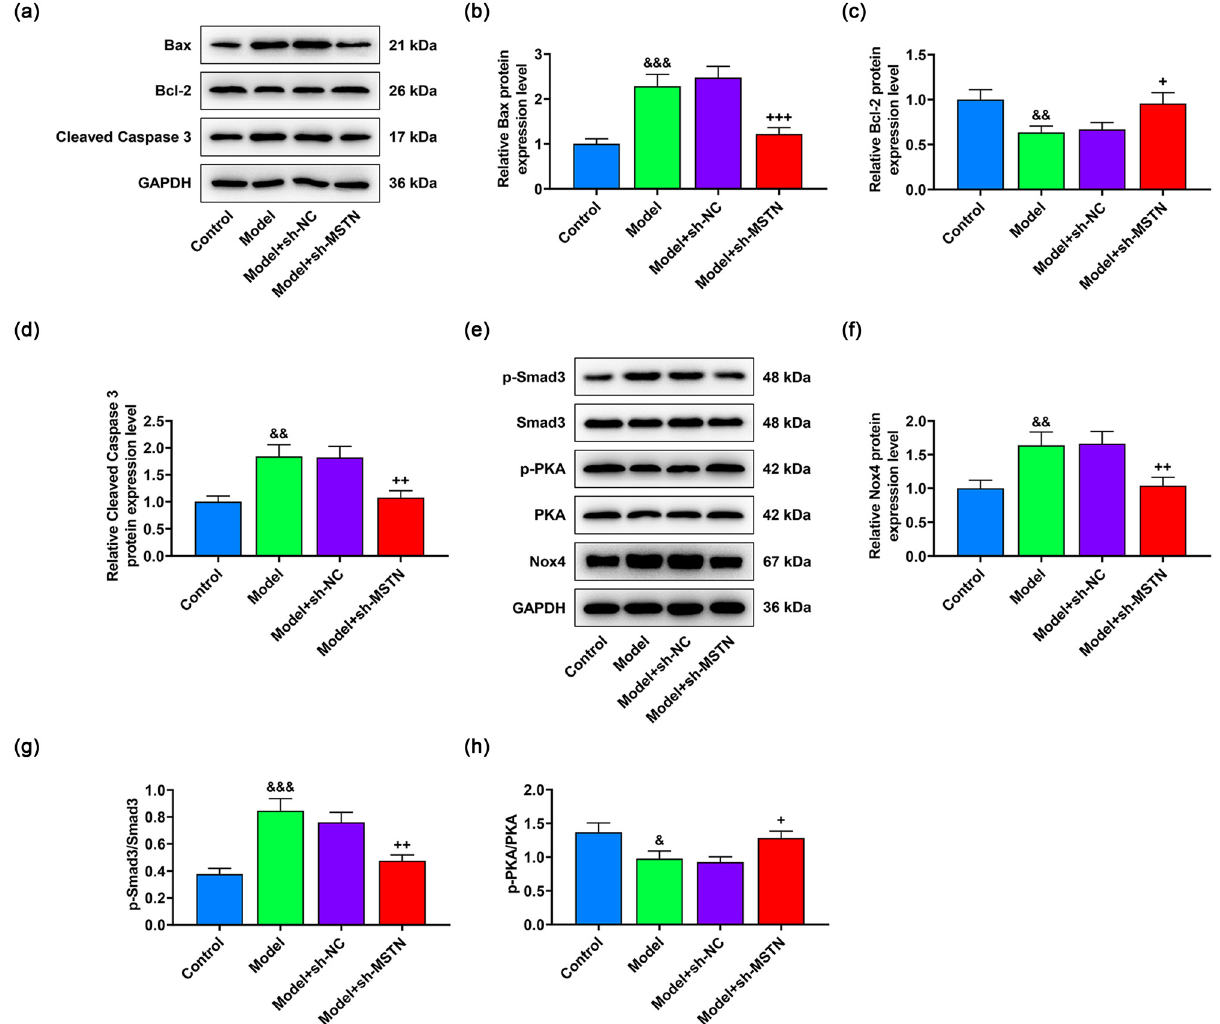
Figure 8: E ff ects of sh - MSTN on the apoptosis and expressions of Smad3/PKA/Nox4 signaling pathway - related proteins in MN model rats. MN model rats were induced by c - BSA and then subjected to injection with 30 pmol/g of sh - MSTN or sh - NC. ( a – d ) Expression levels of the apoptosis - related proteins in rat renal tissues were examined by western blot, with GAPDH acting as the internal reference. ( e – h ) Western blot was also performed to measure the expressions of Smad3/PKA/Nox4 signaling pathway - related proteins in rat renal tissues, with GAPDH functioning as the internal reference. All experiments were repeated three times to obtain average values. The data are presented as the mean ± SD of three independent experiments; & p < 0.05, && p < 0.01, &&& p < 0.001 vs Control; + p < 0.05, ++ p < 0.01, +++ p < 0.001